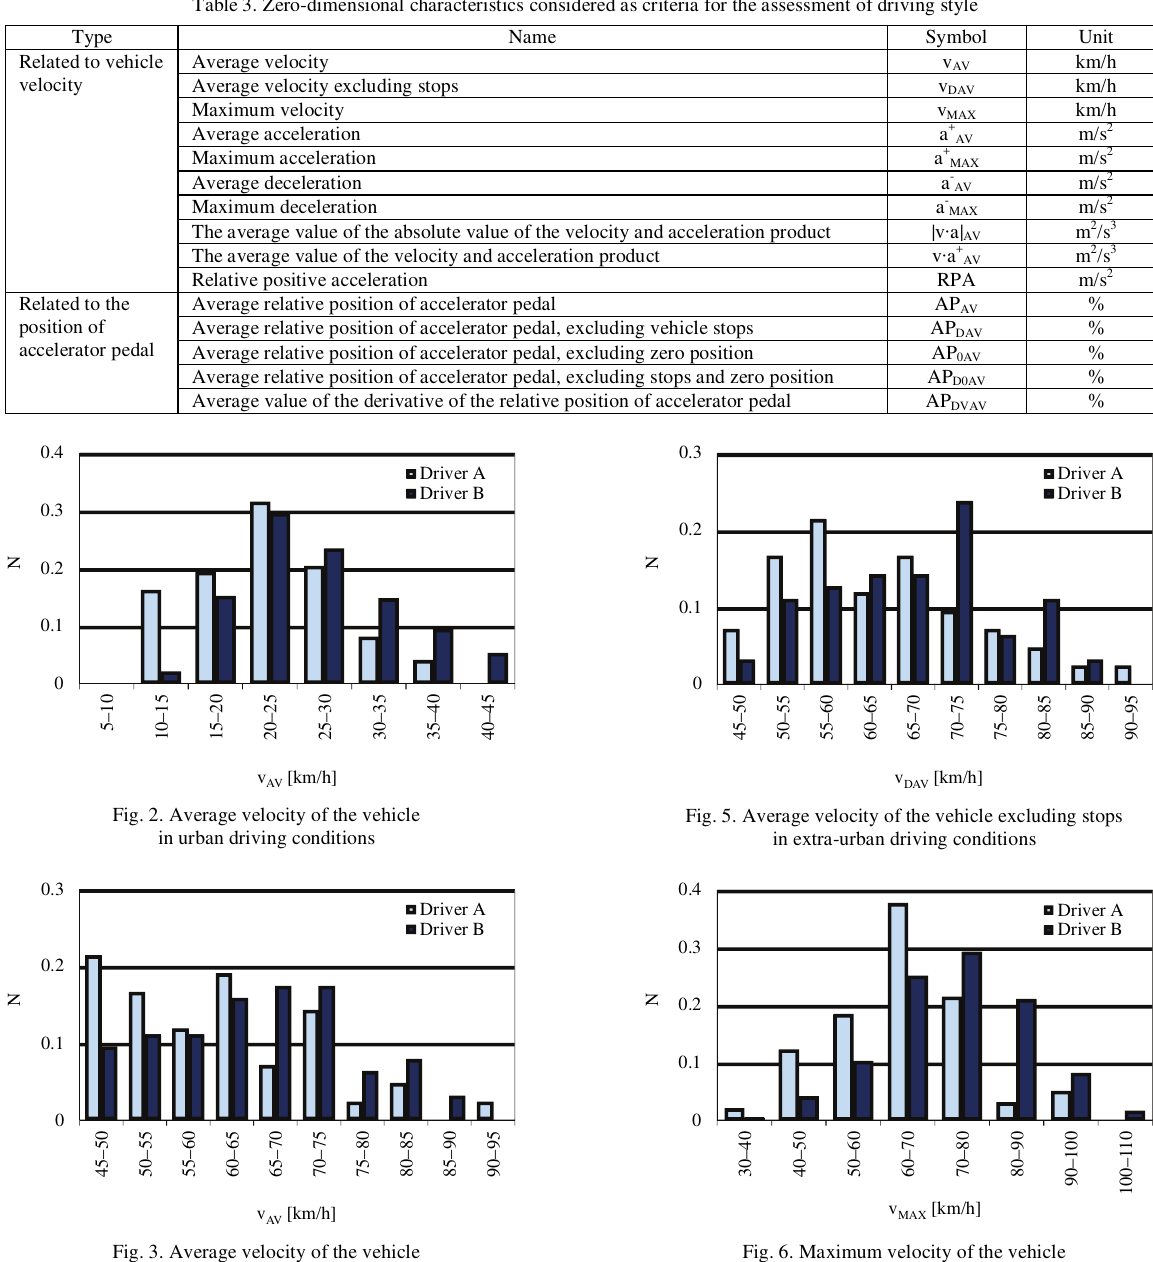
Fig. 3. Average velocity of the vehicle in extra-urban driving conditions